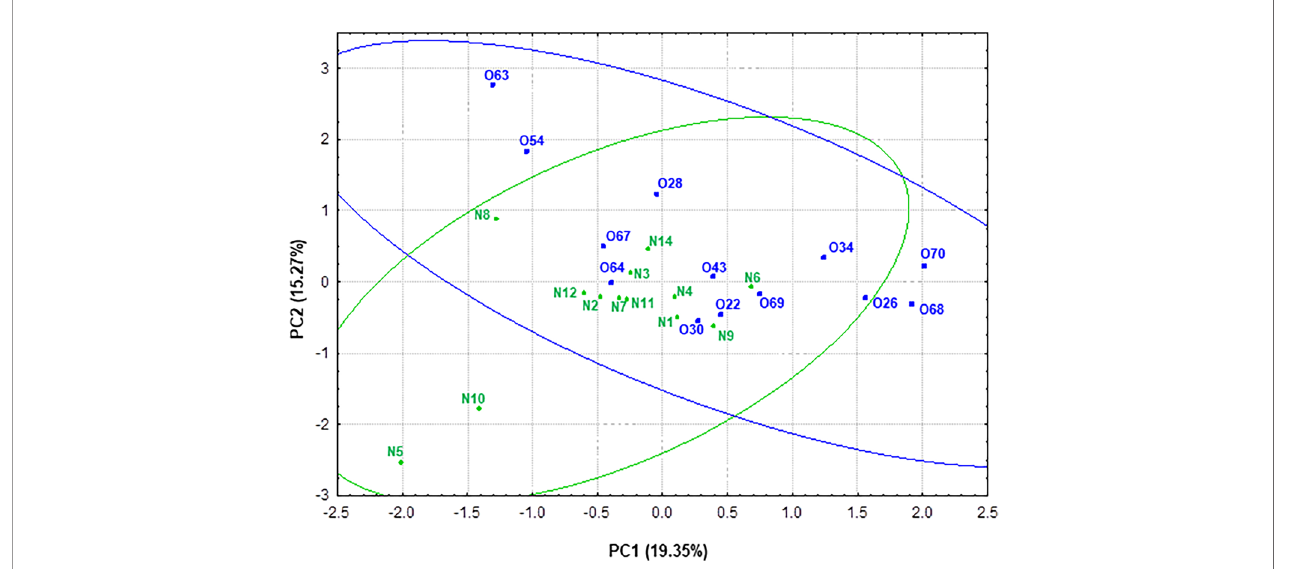
FIGURE 7 | Representation of the samples from normoweight (N) and obese (O) individuals in the plane de fi ned by the two fi rst components (PC1 and PC2) resulting from a PCA that takes into account both genera taxonomic groups and the metabolic activity-SCFAs and